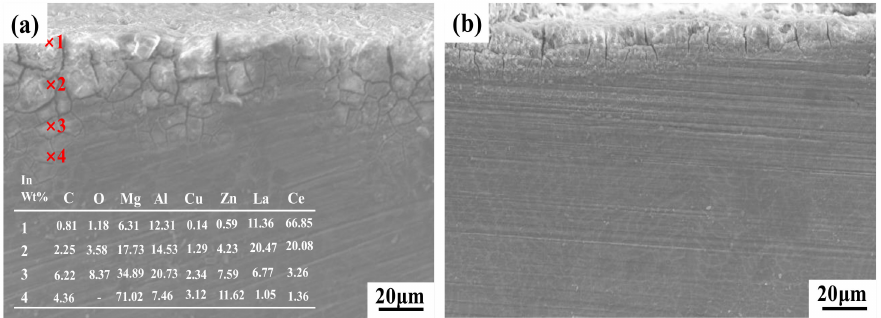
Figure 8. Cross-sectional SEM micrographs of corrosion morphology of ( a ) the Mg-RE alloy ingot sample and ( b ) the sheet with TRC sample in the PBS solution at 310 K for 10